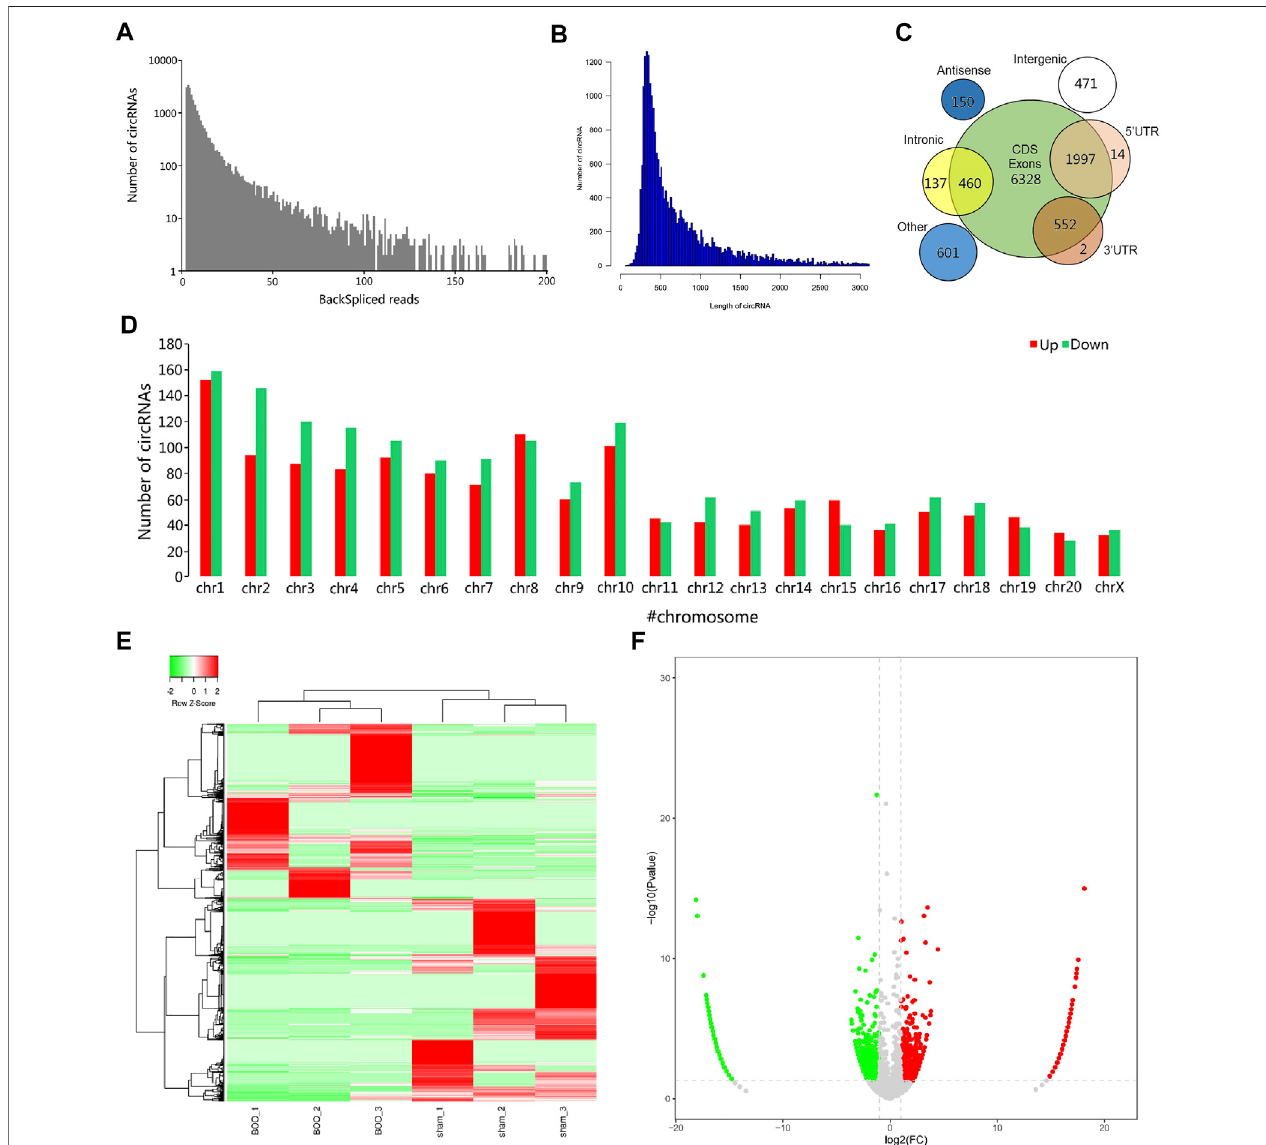
FIGURE1| Characterizationofdifferentially expressed circRNAs in ratBOO model. (A) Frequency distribution ofcircRNAs expression inrat BOOmodel basedon backspliced reads. X axis: the range of total backspliced reads ofcircRNAs. Y axis:the frequency ofcircRNAs. (B) Frequency distribution of circRNAs in rat BOOmodel based on circRNA length. X axis: the range of circRNAs length; Y-axis: the frequency of circRNAs. (C) The numbers of circRNAs in rat bladder tissues with different genomicorigins. (D) NumbersofcircRNAsencodedbydifferentratchromosomes.Theup-anddown-regulatedcircRNAsintheratBOOmodelwereshowninred and green bars respectively. (E) Hierarchical clustering of differential circRNA expression in the rat BOO model. Increased and decreased expression of circRNAs were indicated by red and green lines respectively. (F) A volcano plot showing the differential expression of circRNAs in the rat BOO model. CircRNAs with elevated and reduced expression in the rat BOO model were shown by red and green spots